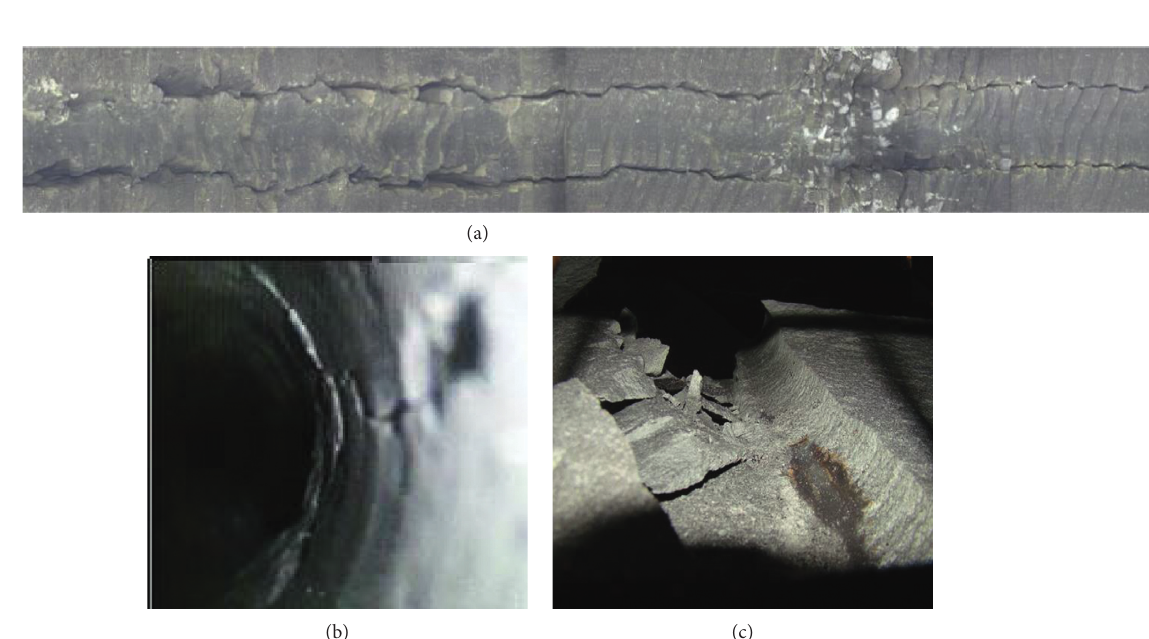
Figure 17: Blast hole cracks: (a) two main cracks; (b) endoscopic view; and (c) blast hole structural